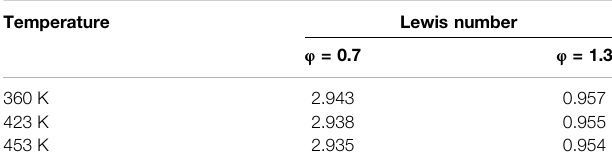
TABLE 5 | Summary of the Lewis number of unburned mixtures in the present work calculated with Hychem detailed mechanism.